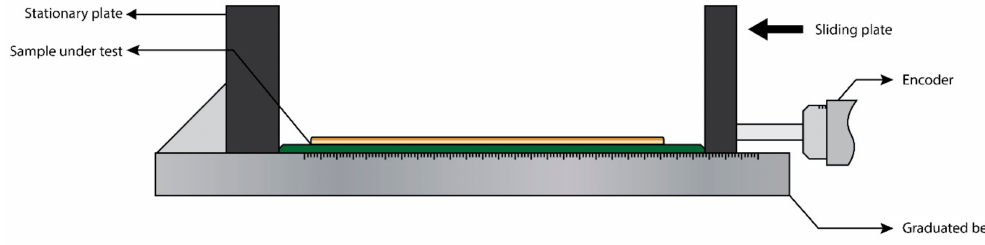
Figure 11. Illustration of a simple bending test for printed electronics. One plate is kept stationary while the other slides along the graduated bed, the distance of which is according to the test radius. The encoder is used to automate the